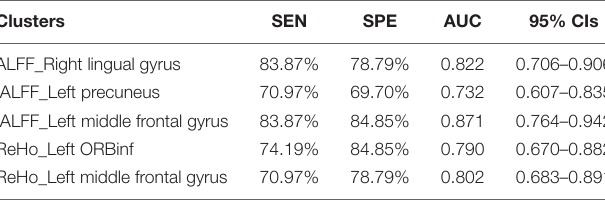
TABLE 5 | The statistics of ROC curve analysis for altered brain clusters.